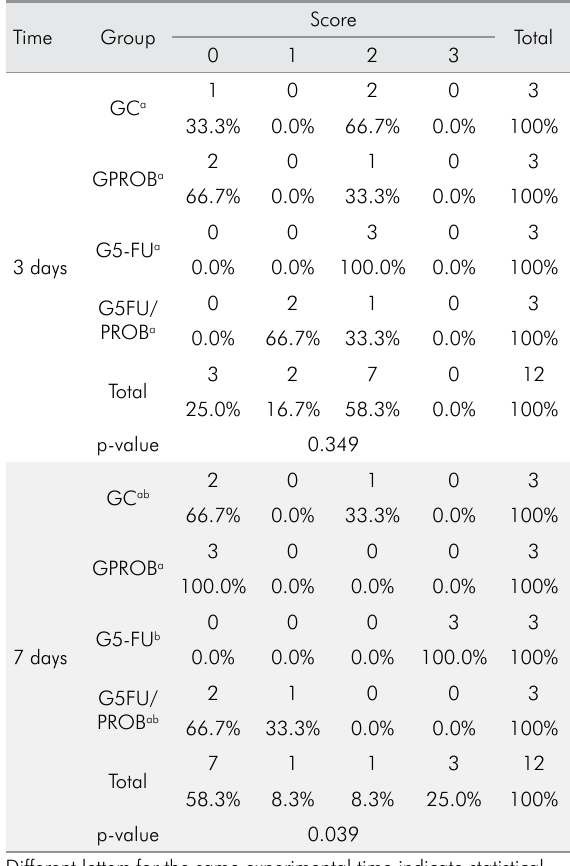
Table 1. Histological score of the jugal mucosa: count and percentage of animals classified according to the respective score (n = 3), with intergroup